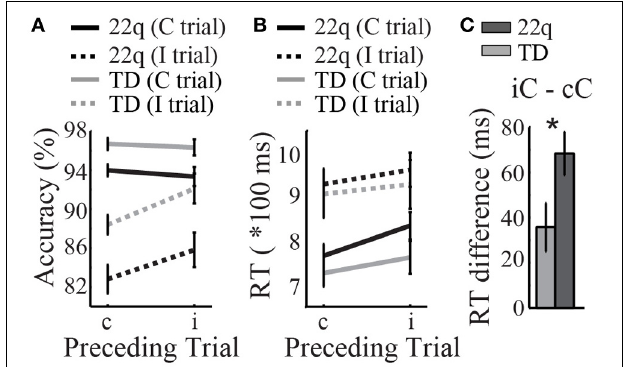
FIGURE 2 | Results of the response inhibition Stroop task. (A) Children with 22q11.2DS had lower accuracy relative to TD participants across all trial types: Congruent ( C ) or Incongruent ( I ) trials preceded by congruent ( c ) or incongruent ( i ) trials, respectively. (B) Response time (RT) was similar between groups. (C) Children with 22q11.2DS were more greatly affected by a preceding interfering stimulus, as measured by a larger RT difference on congruent trials preceded by incongruent trials ( iC ) relative to congruent trials following other congruents trial ( cC ), ∗ p < 0 .